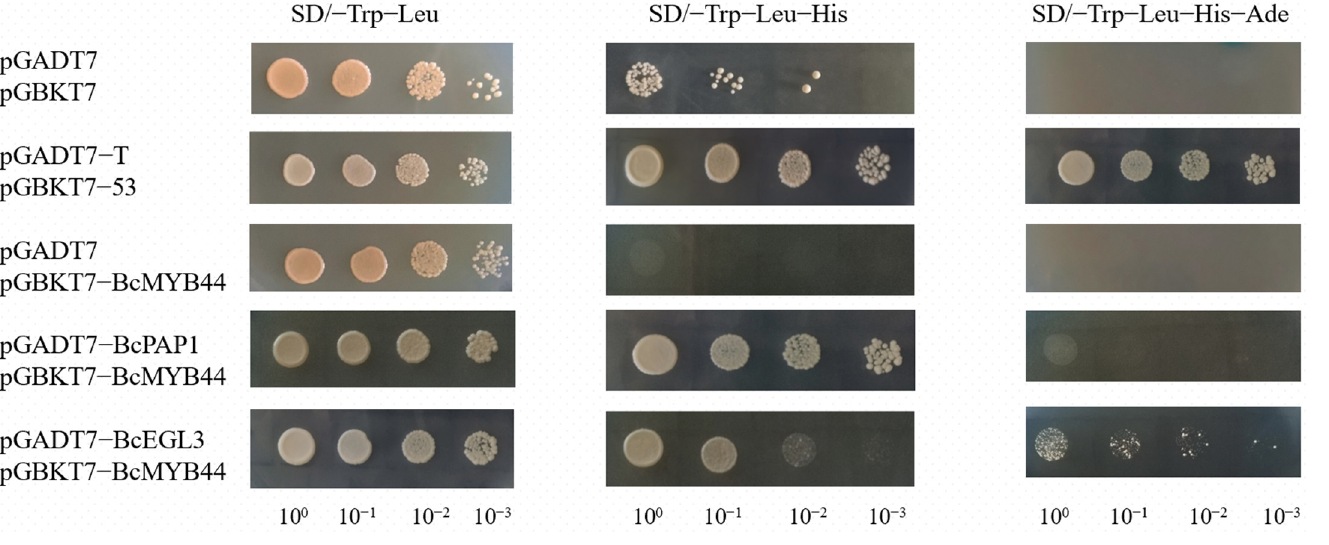
Figure 4. BiFC verification of BcMYB44 and BcPAP1, BcEGL3. Bright: Bright field; GFP: green fluo- rescence signal under GFP-excited light; Merged: superposition of GFP and bright field.BcMYB44-